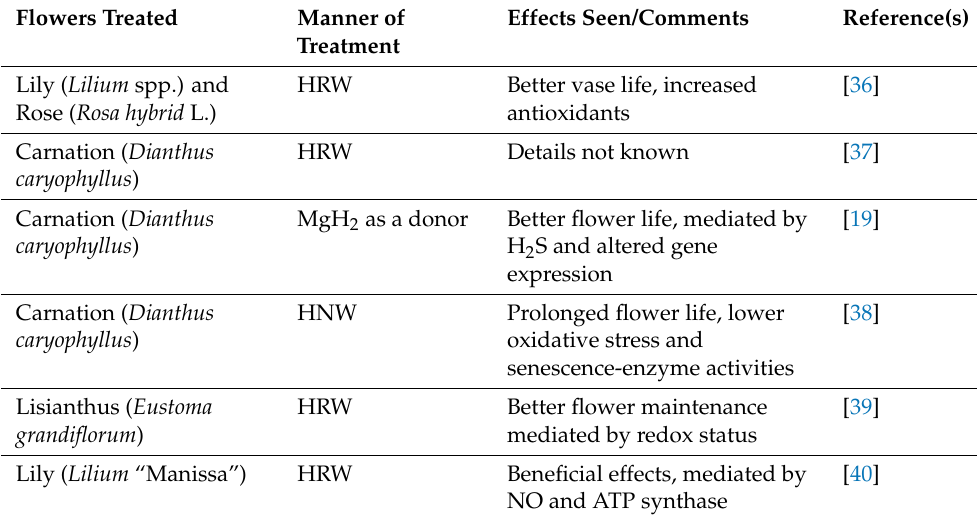
Table 2. Examples of molecular hydrogen treatment of flowers. ATP: adenosine tri-phosphate; HRW: hydrogen-rich water; HNW: hydrogen nanobubble water: H 2 S: hydrogen sulfide; MgH 2 :